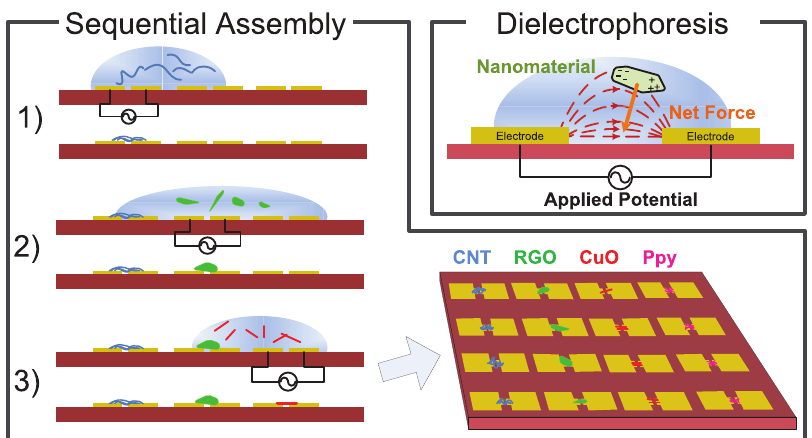
Figure 1. Sequential spatially controlled dielectrophoresis approach: By routing the assembly signal to many electrodes in parallel, many electrodes can be populated simultaneously. This allows the creation of massive, heterogeneous arrays. The premise of dielectrophoresis is shown in the upper right: a polarizable particle in a dielectric medium will experience a net force along the gradient of an applied field.